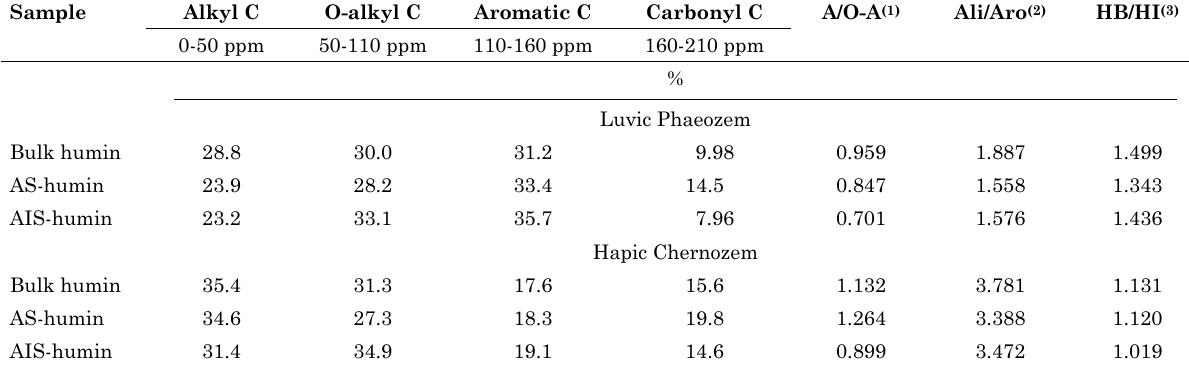
table 3. relative intensities of different carbon functional groups in solid-state 13 C CPmas nmr spectra of bulk humin and its corresponding alkaline-soluble humin (as-humin) and alkaline-insoluble humin (ais-humin) from luvic Phaeozem and hapic Chernozem sample alkyl